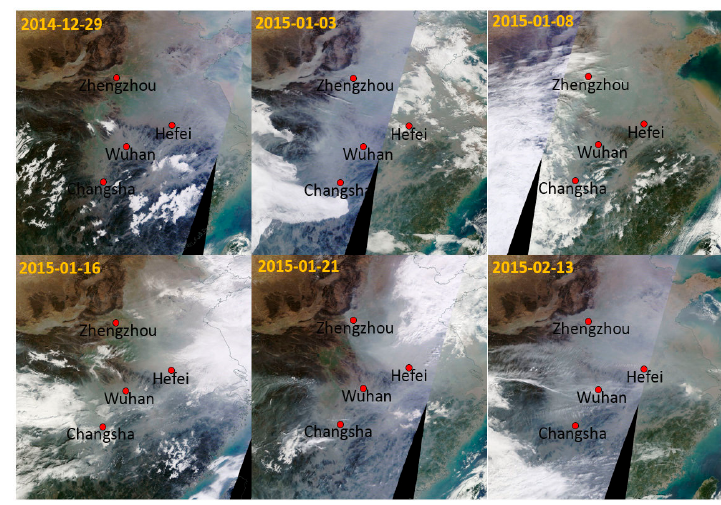
Figure 17. Cases of Terra 1-km MODIS true color images of regional haze pollution over central China during haze events from 11 December 2014 to 26 February 2015.